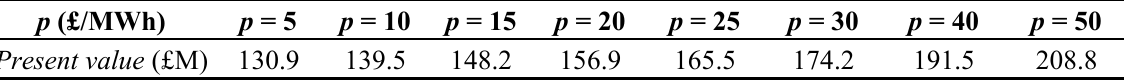
Table 10. Present value under the electricity price plus a